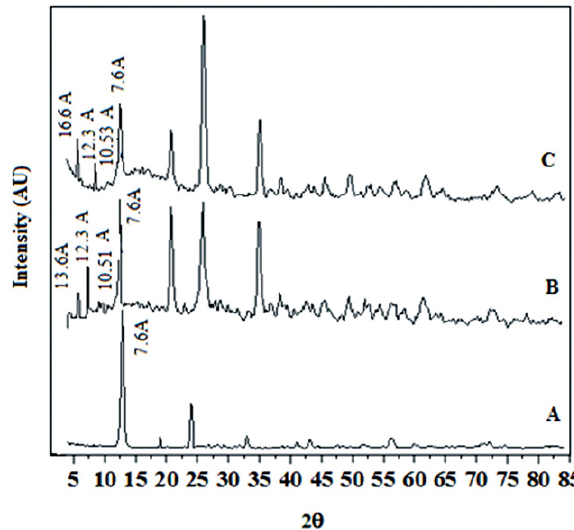
Fig. 6 X-ray diffraction α-ZrP (A), I /ZrP 1:30 (B) and I /ZrP = 1:5